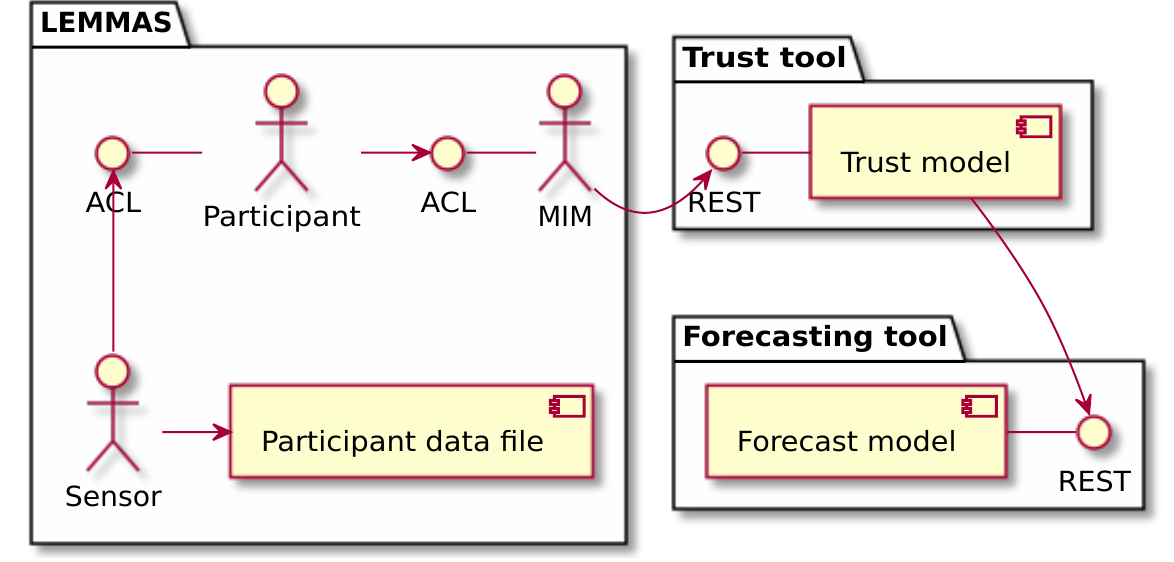
Figure 1. Developed